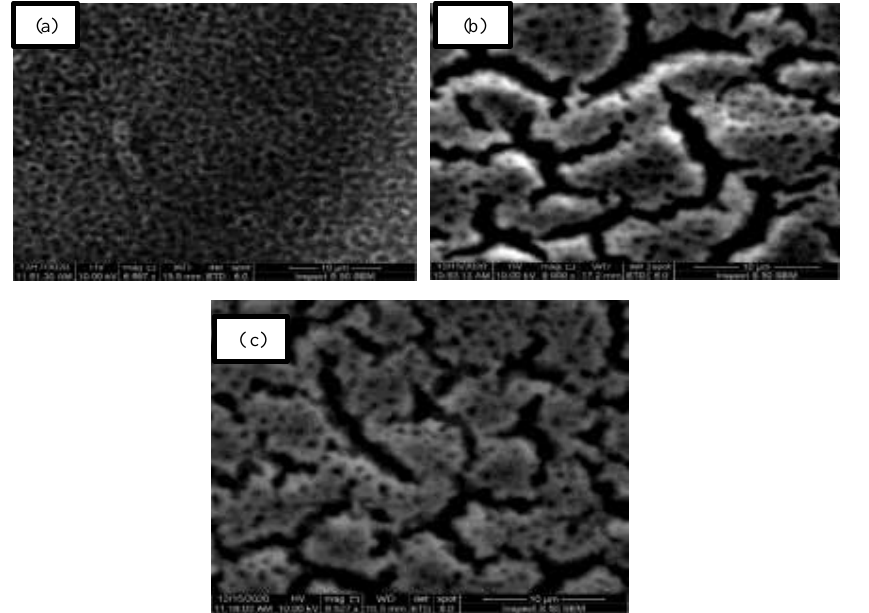
Figure 3: SEM images taken at various etching times of 5, 15, and 25 minutes, with an etching current density of 20mA/cm 2 at HF concentration 20%.